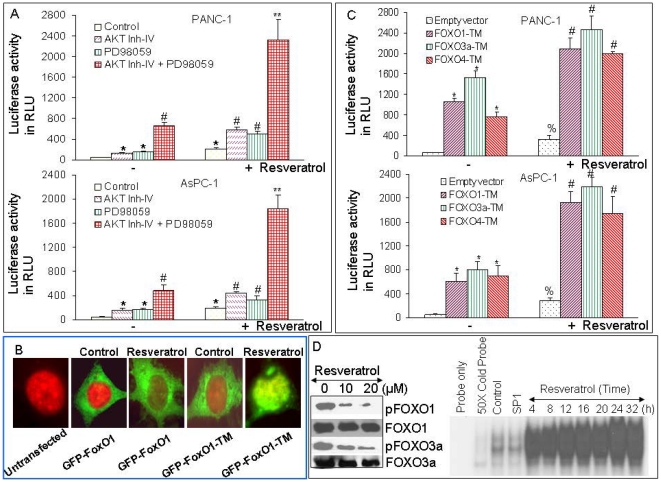
Inhibition of PI3K/AKT and MEK/ERK pathways synergistically/additively enhanced resveratrol -induced apoptosis and FOXO transcriptional activity in pancreatic cancer cells.(A), PANC-1 and AsPC-1 cells were transiently transfected with 6× DBE-luciferase construct for 24 h. After transfection, cells were pretreated with AKT inhibitor IV (1 µM) and/or MEK1/2 inhibitor PD98059 (10 µM) for 2 h, followed by treatment with or without resveratrol (10 µM) for 24 h. Cells were harvested for firefly/Renilla luciferase assays using the Dual-Luciferase Reporter Assay System (Promega). Luciferase counts were normalized using Renilla luciferase transfection control (pRL-TK; Promega). Data represent the mean ± S.D. *, # and ** = significantly different from respective controls, P<0.05. (B), Resveratrol induces translocation of wild type and triple mutant FOXO1 to nucleus. Pancreatic cancer PANC-1 cells were transfected with either GFP-FOXO1 or GFP-FOXO-TM and treated with resveratrol (10 µM) for 24 h. Cells were visualized by fluorescence microscopy. (C), Phosphorylation deficient mutants of FOXO (triple mutants) enhance resveratrol-induced FOXO transcriptional activity in pancreatic cancer. PANC-1 and AsPC-1 cells were transiently transfected with empty vector or constructs encoding FOXO1-TM, FOXO3a-TM, or FOXO4-TM together with 6× DBE-luciferase for 24 h. After transfection, culture medium was replaced with complete RPMI, treated with resveratrol (10 µM) for 24 h, and harvested for firefly/Renilla luciferase assays using the Dual-Luciferase Reporter Assay System (Promega). Luciferase counts were normalized using Renilla luciferase transfection control (pRL-TK; Promega). Data represent the mean ± S.D. *, % and # = significantly different from control, P<0.05. (D) Left panel, Resveratrol inhibits cytoplasmic phosphorylation of FOXO1 and FOXO3a. PANC-1 cells were treated with resveratrol (0, 10 and 20 µM) for 36 h, and cytoplasmic fractions were prepared. The expressions of p-FOXO1 and p-FOXO3a were measured by the Western blot analysis. Right Panel, FOXO-DNA binding. PANC-1 cells were treated with or without resveratrol (10 µM) for various time points (0–32 h). Nuclear extracts were prepared. Gelshift assay was performed as we described in Material and Methods. Lane 1 = probe only, lane 2 = 50× cold probe, lane 3 = control, lane 4 = cell lysates from control samples treated with SP1 probe, lanes 5–11 = cell lysate from resveratrol treated samples at 4, 8, 12, 16, 20, 24 and 32 h.